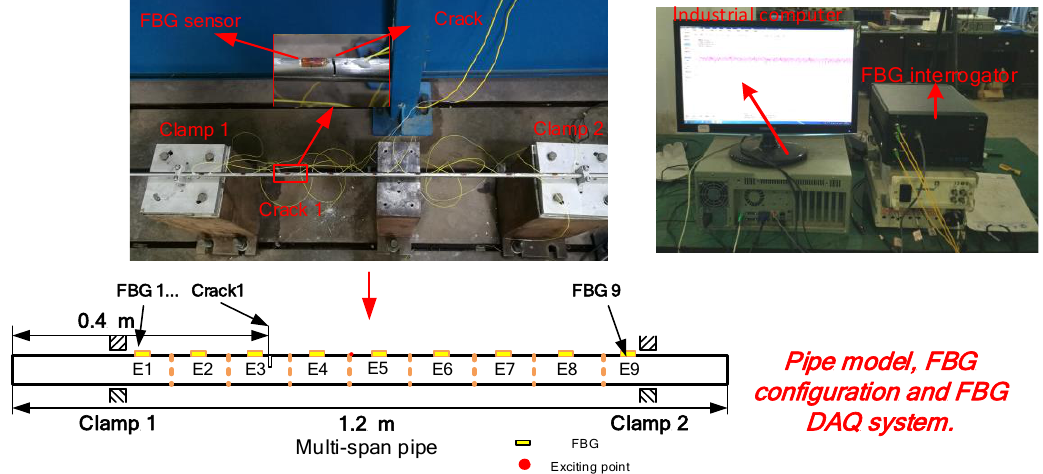
Figure 9. The configuration of the hydraulic pipeline test rig.